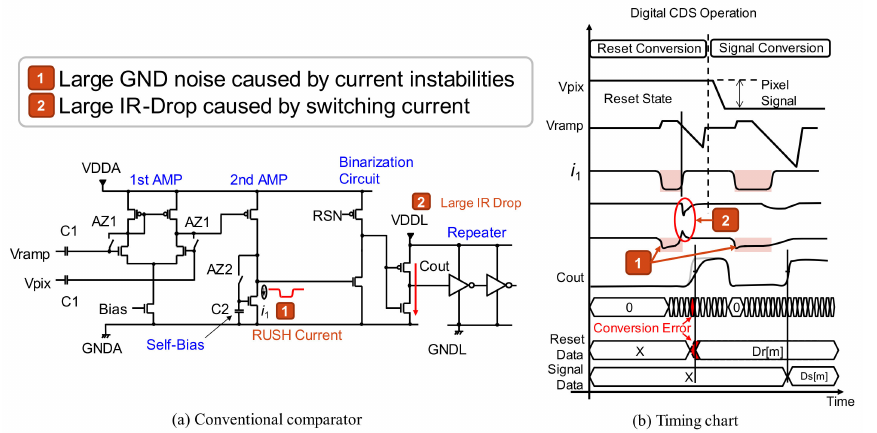
Figure 2. ADC comparator of conventional